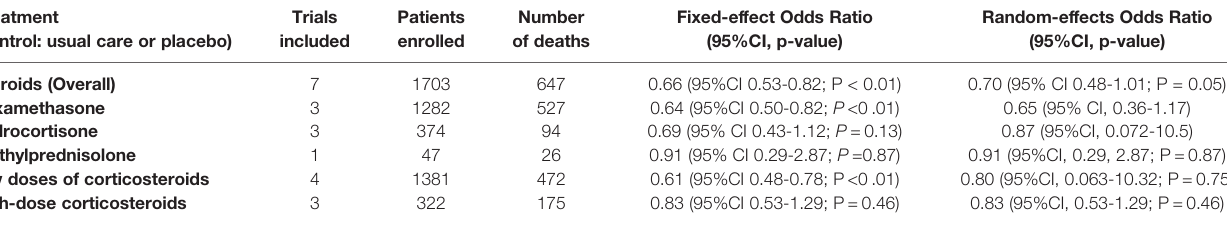
TABLE 2 | The association between use of corticosteroids and 28-day all-cause mortality among patients with COVID-19, according to meta-analysis by REACT working group. Treatment Trials (control: usual care or placebo)